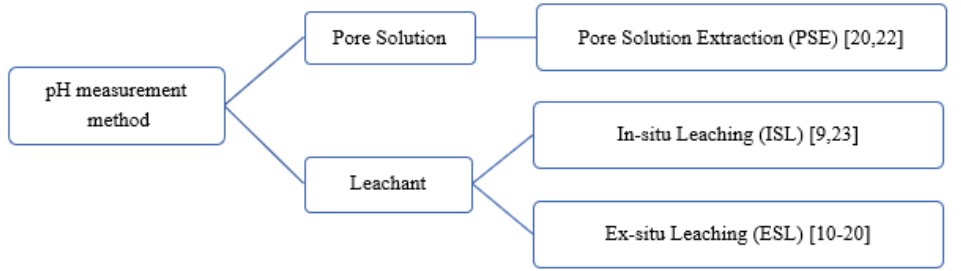
Figure 1. pH measurement methods categorised by different types of sample preparation.